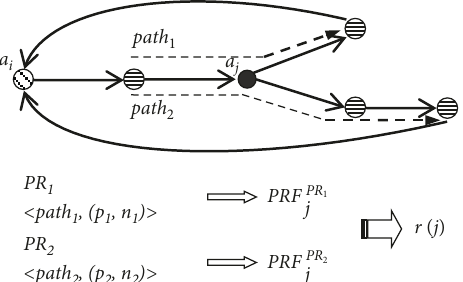
Figure 4: Example for aggregation from path reputations to in- dividual reputations of agents. (The aggregation is taken by agent a i ; and a j is the target